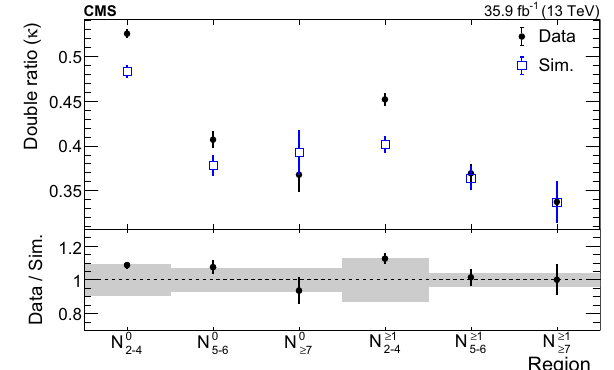
Fig. 3 The double ratio κ in each N jets - N b-jets region for zero-photon events. The filled black circles are the observed κ values after subtract- ing the electroweak contamination based on simulation. The open blue squares are the κ values computed directly from simulation. The ratio is shown in the bottom panel, where the shaded region corresponds to the systematic uncertainty in the γ +jets prediction. In the label N b refers to the number of jets and b refers to the number of b-tagged jets